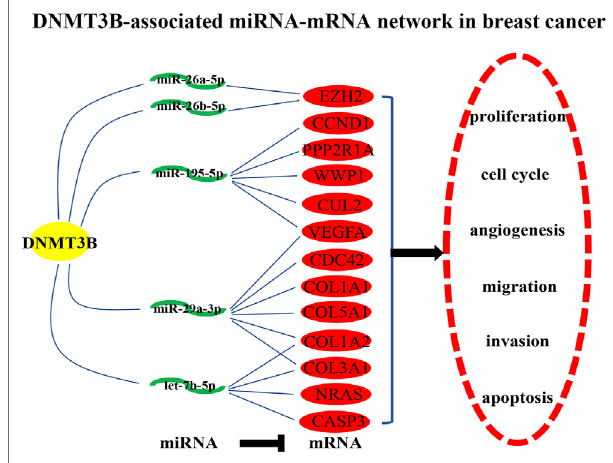
FIGURE 6 | Construction of a potential DNMT3B-associated miRNA – mRNA network in breast